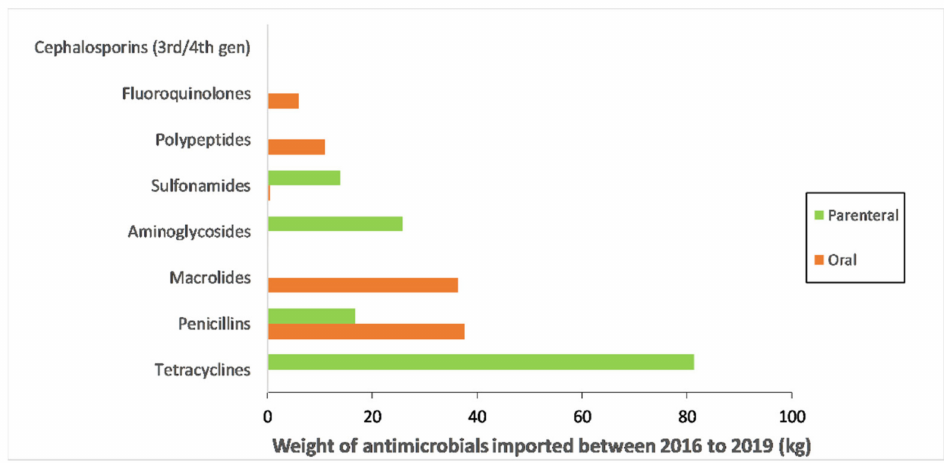
Figure 2. Total weight of veterinary antimicrobials imported into Timor-Leste between 2016 and 2019, by route of administration and antimicrobial class. Antimicrobials for administration via the topical route represented less than 0.3 kg (0.1%) of total imports and were therefore not included in the